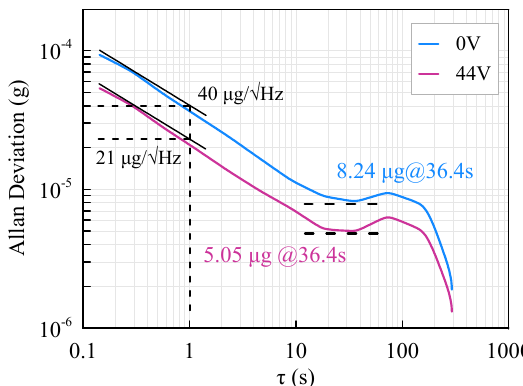
Figure 14. Allan deviation of the accelerometer.